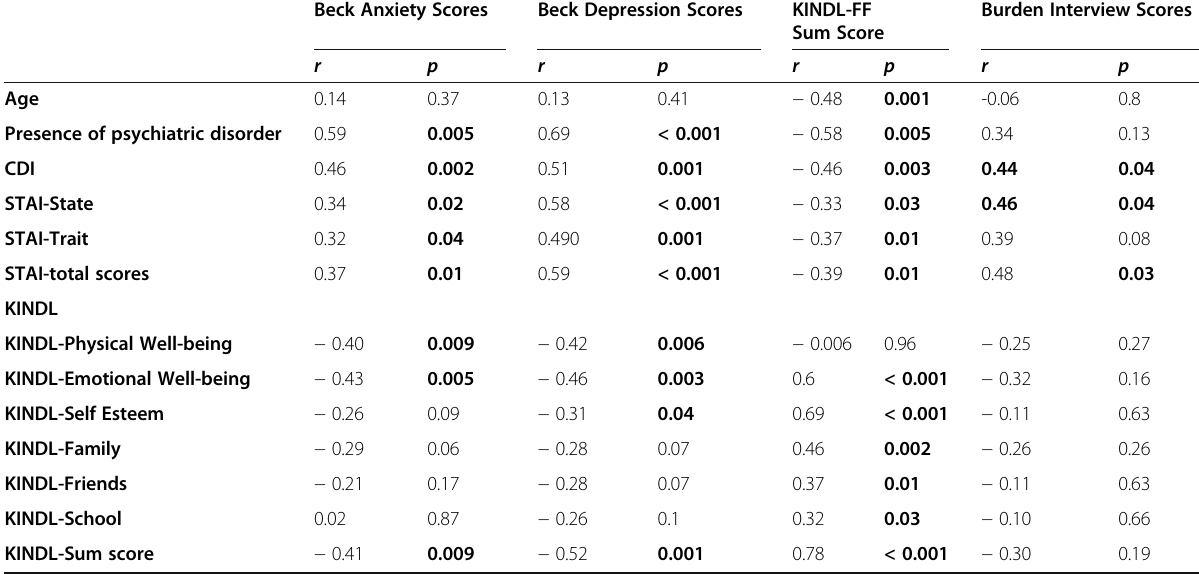
Burden Interview Sum Score